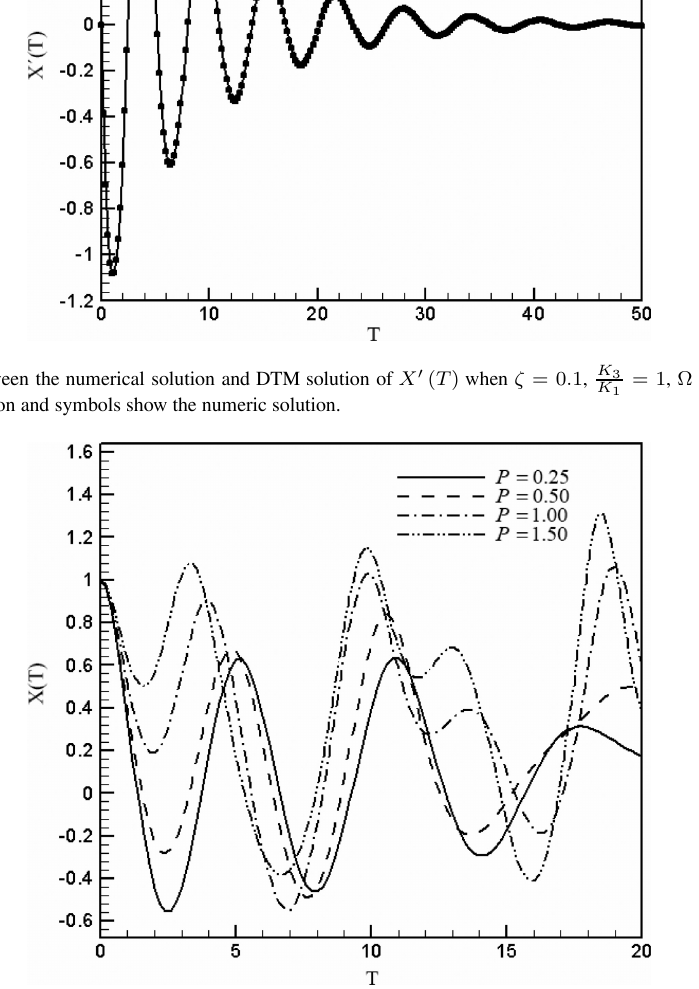
Fig. 6. The solution of X ( T ) by DTM for various P , when ζ = 0 . 1 , K 3 K